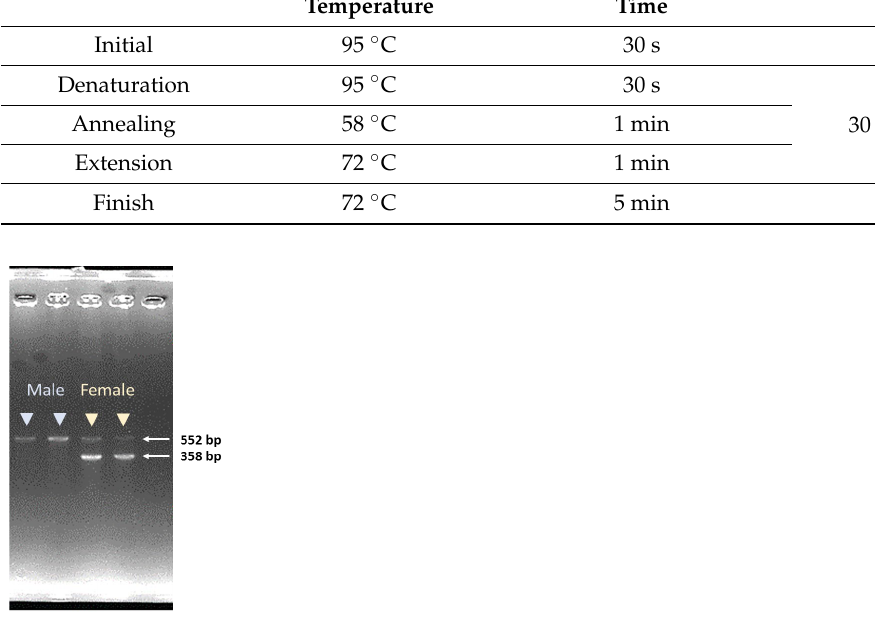
Figure 3. Sex identification for chick fetus using PCR. One single band at 552 bp indicated a male fetus and two bands at 552 bp and 358 bp indicated a female fetus. fetus and two bands at 552 bp and 358 bp indicated a female fetus.